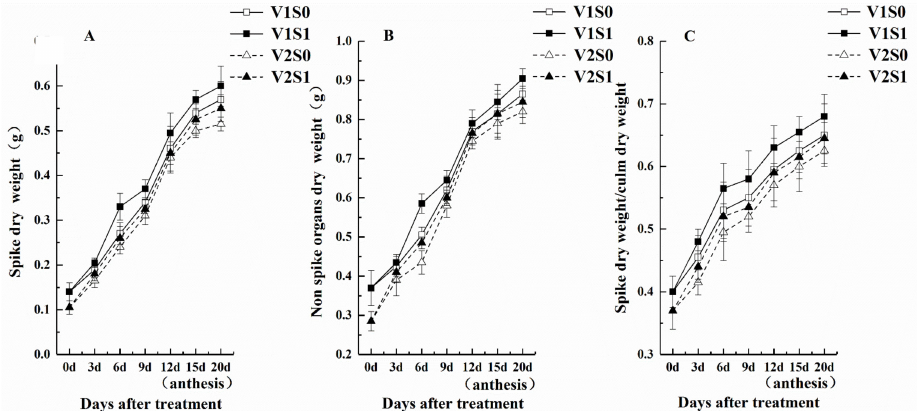
Figure 3. Di ff erences of dry matter accumulation in spike and non-spike organs under exogenous 6-BA treatment and the control in wheat. The e ff ects of 6-BA on spike dry weight ( A ), non-spike organs dry weight ( B ), and dry weight in spike / culm ( C ) during 2016–2018,